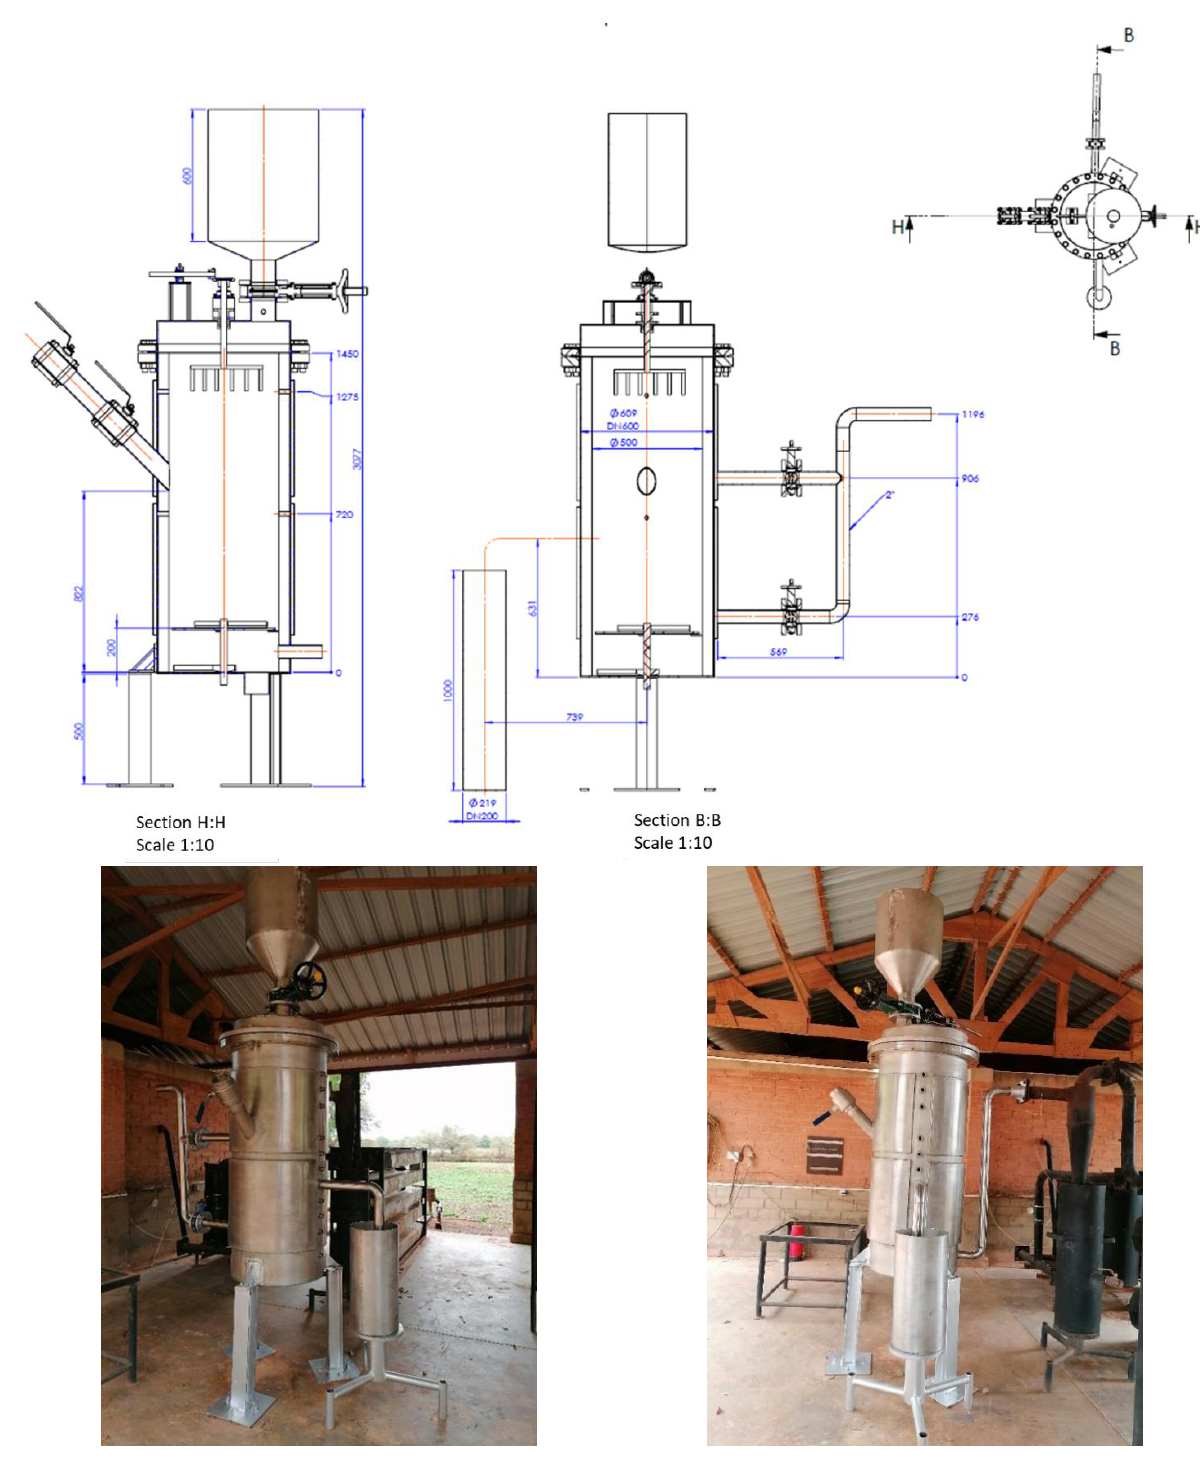
Figure 7. The technical plans of the selected gasifier and the manufactured prototype.